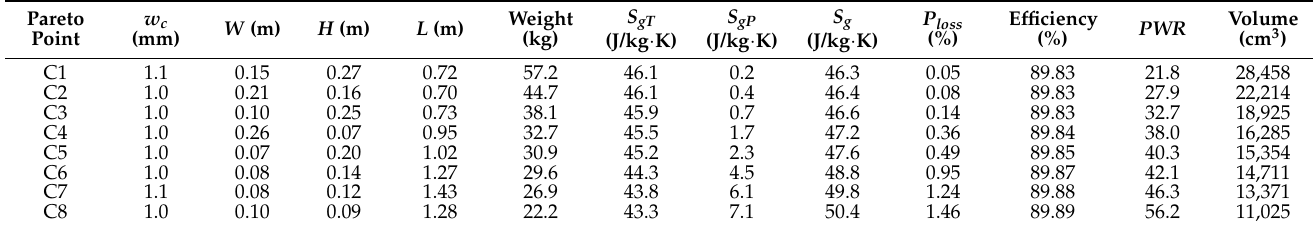
Figure 13. The relationship between S gP and S gT . Table 7. Parameters of C1~C8.